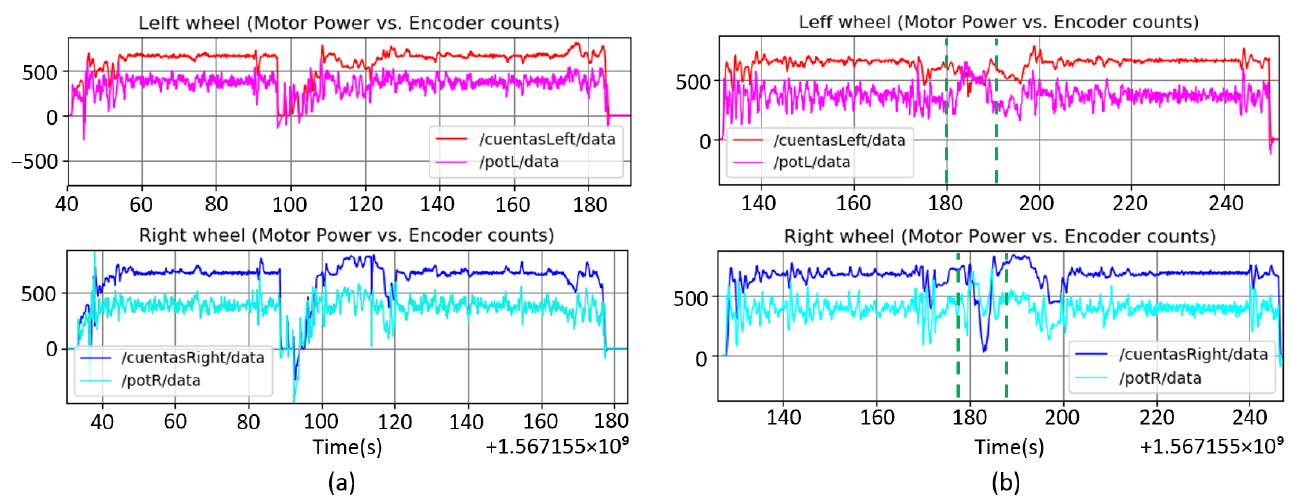
Figure 3. Motor power vs. encoder counts for both wheels.( a ) Without slipping and ( b ) with